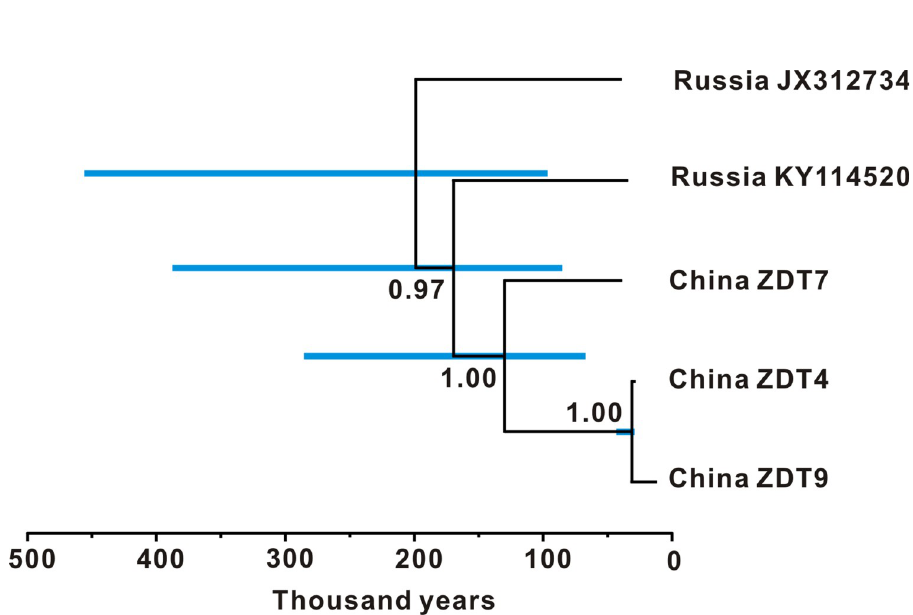
Fig 2. Maximum-likelihood phylogenetic tree of complete mitochondrial genomes of equids, rooted using the Hippidion clade as outgroup. Branch labels show the bootstrap values derived from 1000 replications. Ages of E . ovodovi specimens are indicated following the sample/accession number.